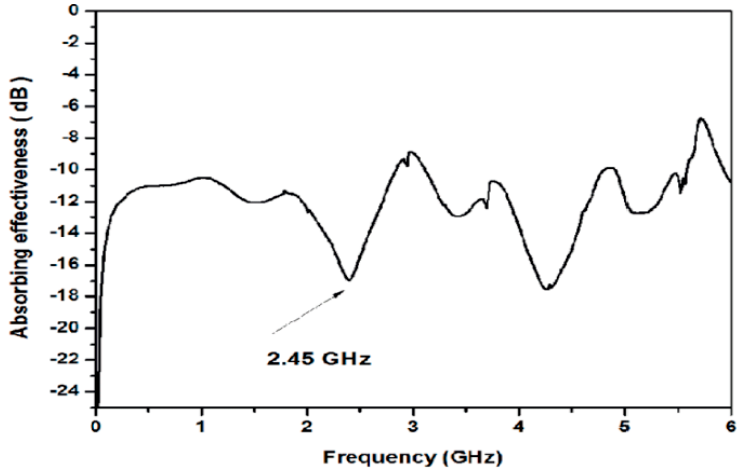
Figure 1. Microwave spectrum of neat PPDA.